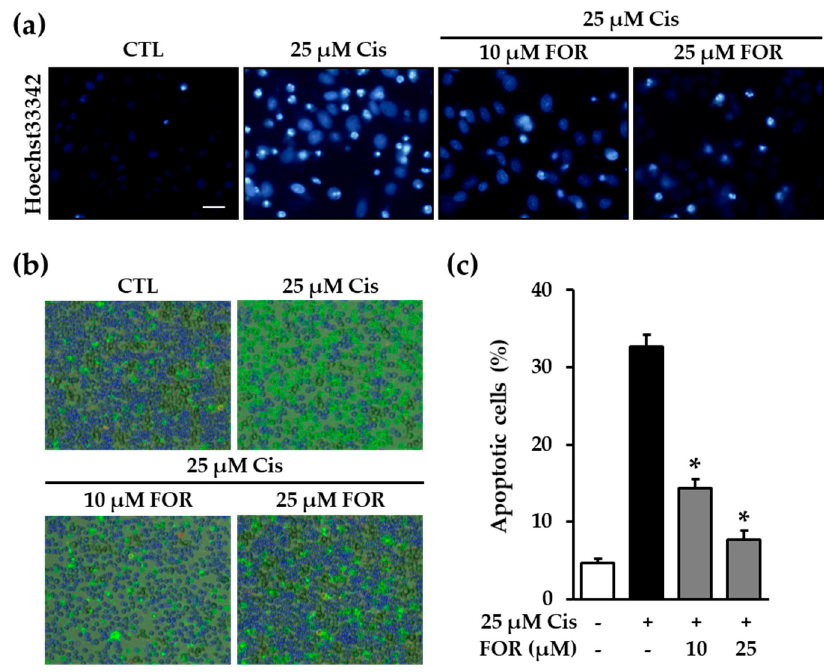
Figure 5. Formononetin attenuates cisplatin-induced apoptosis in LLC-PK1 cells. ( a ) LLC-PK1 cells were exposed to 25 μ M cisplatin for 24 h in the presence of formononetin followed by staining with Hoechst-33342. Bright blue indicates the chromatin condensation. Scale bar, 50 μ m; ( b ) representative images (40× magnification) were obtained using Tali-image–based cytometric analysis to determine the apoptotic cells (blue: live cells, green color: Annexin V positive cells); ( c ) bars indicate the percentage of apoptotic cells (mean ± S.E.M., * p < 0.05 compared with cisplatin-treated cells).